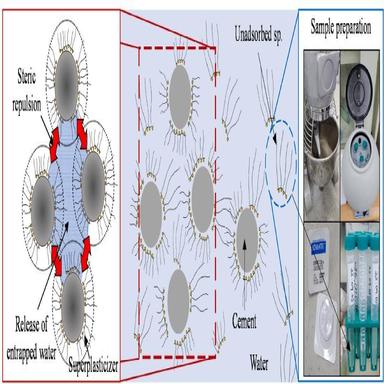
Characteristics of superplasticizer adsorption, and solution extraction method for preparing sample.